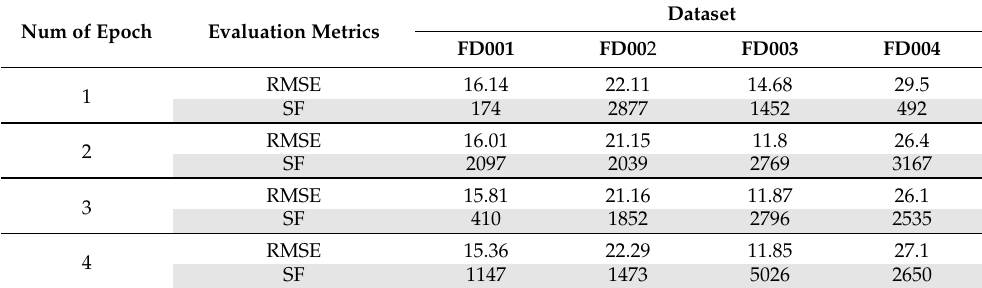
Table 5. Performance analysis of the asynchronous FedLSTM.